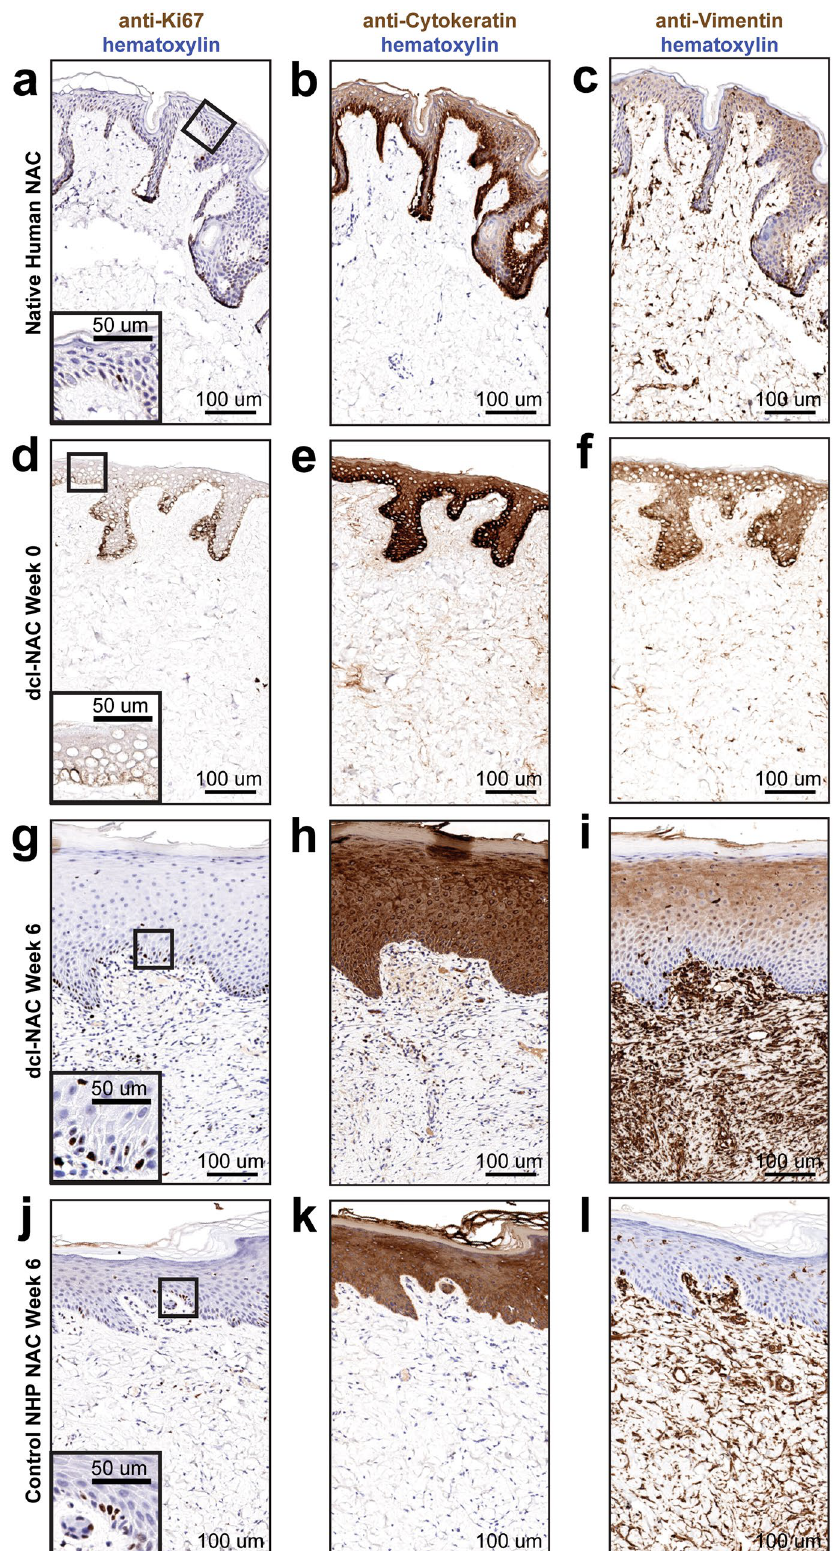
Figure 4. Histological analysis of cell types in re-cellularized dcl-NACs and controls. ( a , d , g , j ) Ki67 (brown) stains proliferative cells. ( b , e , h , k ) Pan-CK (brown) stains keratinized cells. ( c , f , i , l ) Vimentin (brown) stains fibroblasts, and hematoxylin (blue) stains cell nuclei. ( a – c ) Intact, non-decellularized human NAC. ( d – f ) non- engrafted dcl-NAC. ( g – i ) dcl-NAC 6-weeks post-engraftment. ( j – l ) Intact, non-decellularized, native NHP NAC 6-weeks